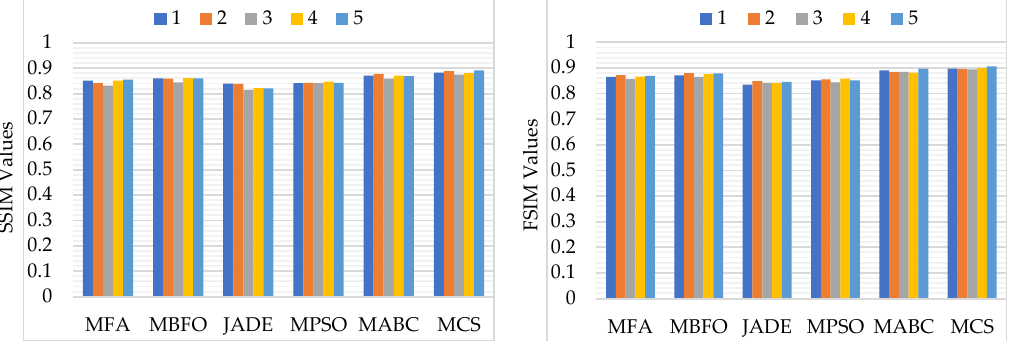
Figure 8. SSIM and FSIM using different optimization algorithms with MCE.